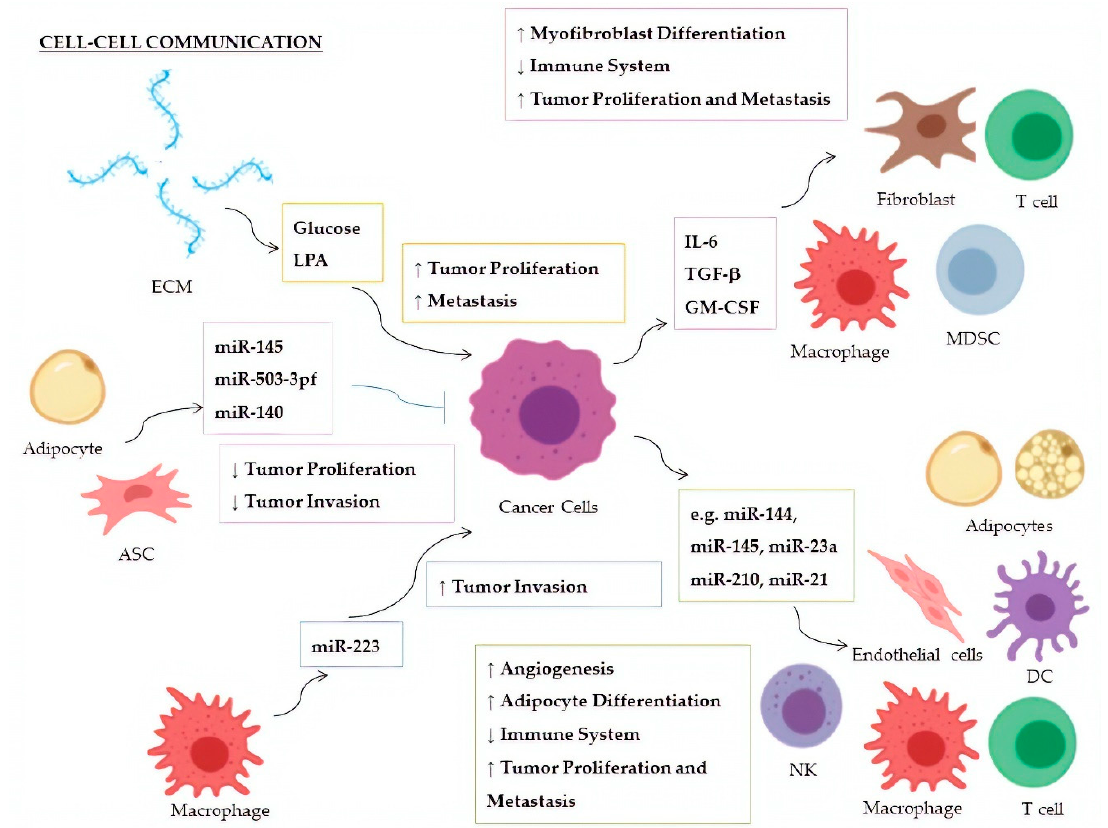
Figure 1. Cell–cell communication within the tumor microenvironment: On the left, factors and ECmiRNAs released by cells or extracellular matrix toward cancer cells; on the right, factors and ECmiRNAs released by cancer cells that stimulate biological pathways in recipient cells. ↑ Upregulation; ↓ Downregulation; ASC: Adipose-derived Stem Cell; DC: Dendritic Cell; ECM: Extracellular Matrix; LPA: Lysophosphatidic Acid; MDSC: Myeloid-derived suppressor cell; NK: Natural Killer cell.